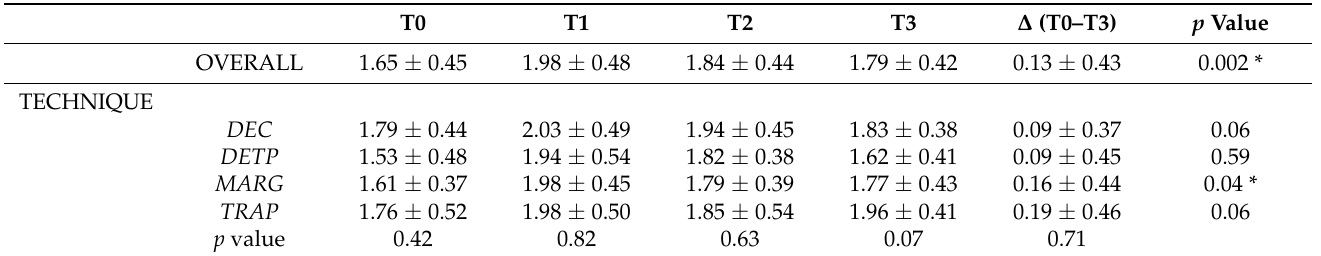
Table 5. First molar buccal site PPD. Values are presented in mm as mean ( ± standard deviation).